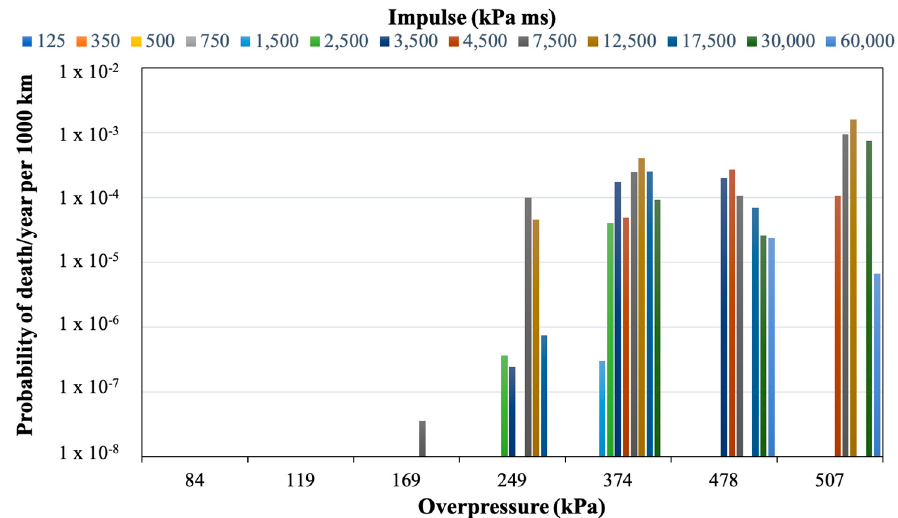
Figure 2. Probability of death from lung hemorrhage for explosive class 9 and atmospheric stability class F2.